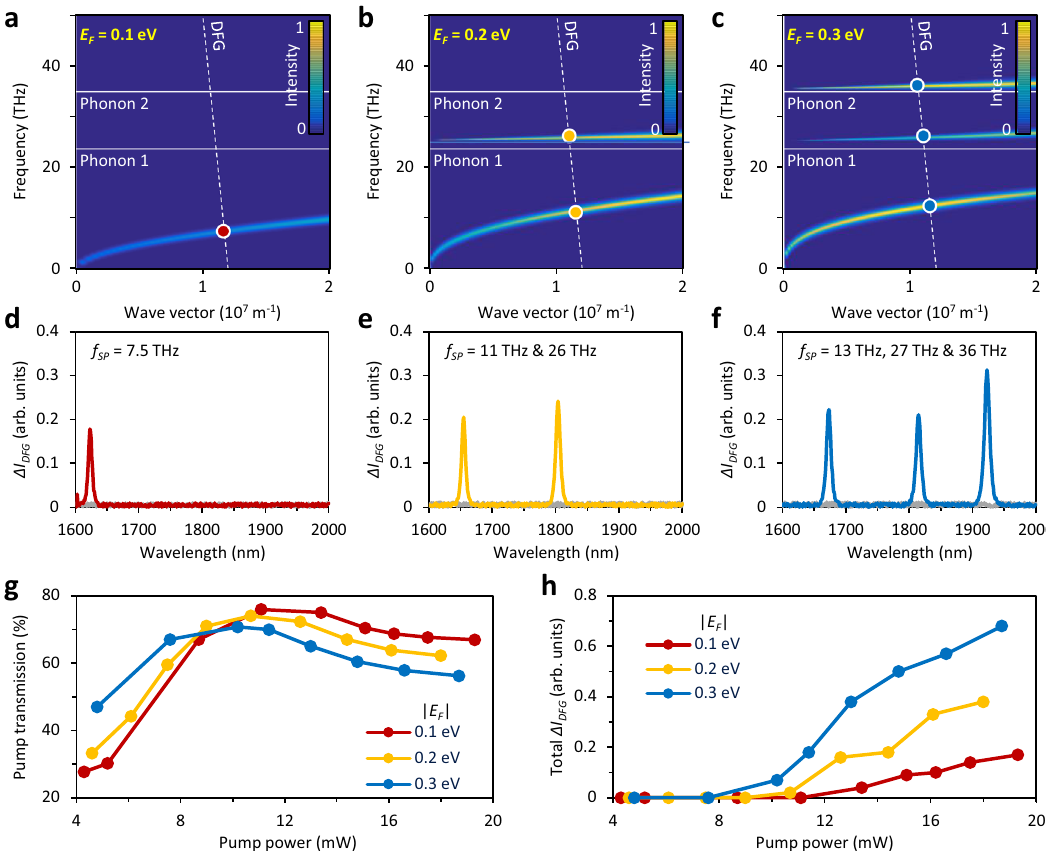
Fig. 2 DFG signal and electrically tunable plasmons. a – c Phase-matching condition (white dashed line) and graphene ’ s plasmonic dispersion for |E F | = 0.1, 0.2 and 0.3 eV. The red, yellow and blue dots mark the ‘ frequency-momentum ’ position of the nonlinearly generated plasmons. White solid lines: Phonon resonances of the silica substrate. Colour bar: normalized intensity. d – f Measured Δ I DFG peaks. Red, yellow and blue curves plot the cases when |E F | = 0.1, 0.2 and 0.3 eV, respectively. In these panels, the grey curves show the results measured in a D-shaped fi bre without graphene for comparison. Colour bar of the maps shows normalized plasmonic intensity. g Pump transmission in the GDF device. The pump transmission fi rst increases due to saturable absorption, and then decreases due to nonlinear DFG consumption. h The total Δ I DFG increases linearly with the pump